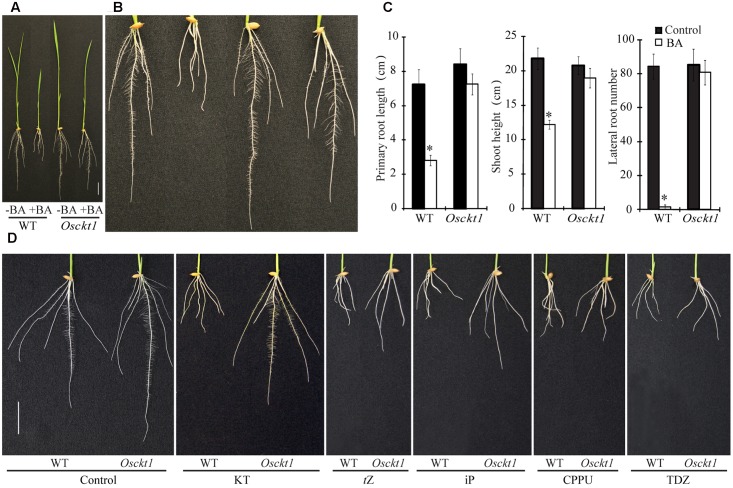
Phenotypic characterization of the wild-type (WT) and Osckt1.
(A) Growth of 8-day-old seedlings of the WT and Osckt1 without or with 0.2 μM 6-Benzylaminopurine (BA) treatment. (B) Enlarged view of roots of the WT and Osckt1 from (A). (C) Effect of BA treatment on lateral root number, shoot height, and primary root length of the WT and Osckt1. Significant differences were determined using Student’s t-test (∗P < 0.05). (D) Root growth of 8-day-old WT and Osckt1 under treatments of 0.2 μM KT, 0.05 μM tZ, 0.1 μM iP, 0.02 μM CPPU, and 0.02 μM TDZ. Bars = 2 cm.